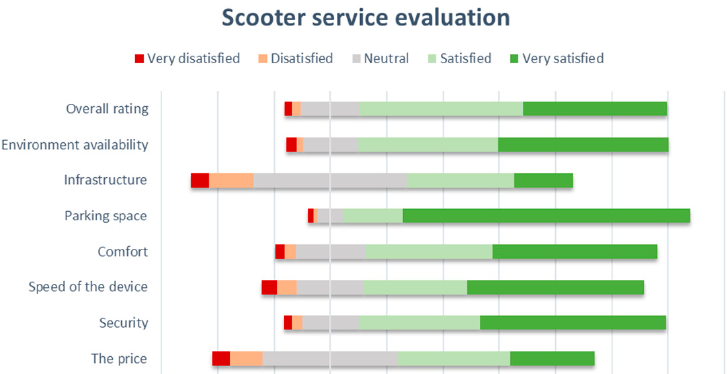
Figure 2. Evaluation of scooter services in Slovakia.